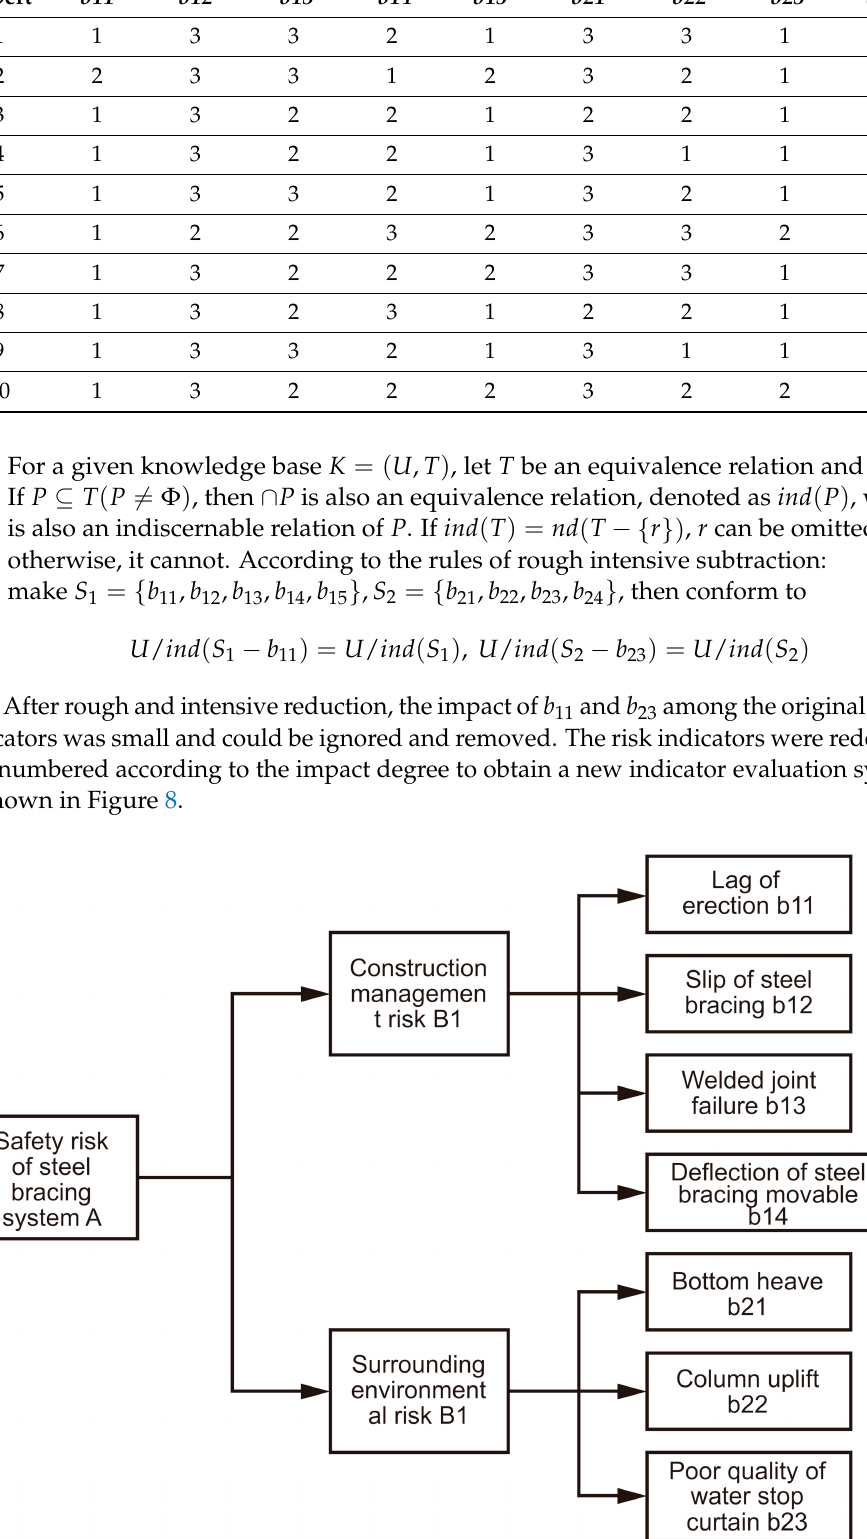
Figure 8. Safety risk evaluation index system for a steel bracing system of a foundation pit.